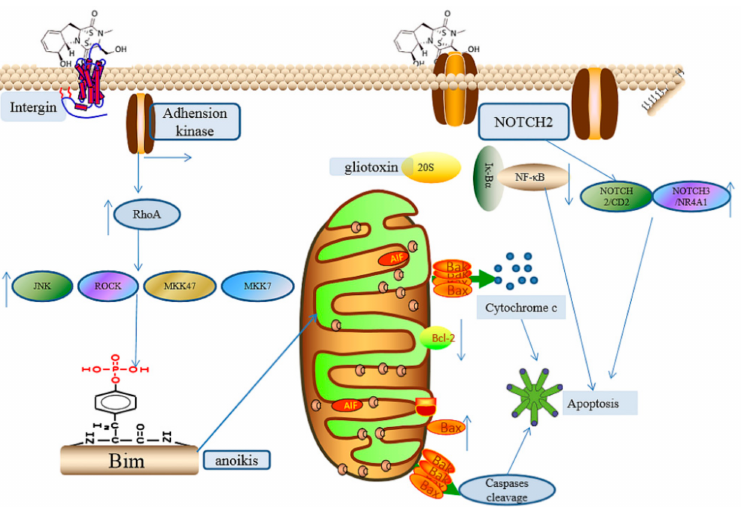
Figure 4. Gliotoxin-mediated apoptosis via different signal pathways. The arrows besides the specific protein indicates the alternation of expression levels of target proteins caused by gliotoxin. For example, the upward arrow of RhoA indicates that the expression level of RhoA is up-regulated by gliotoxin